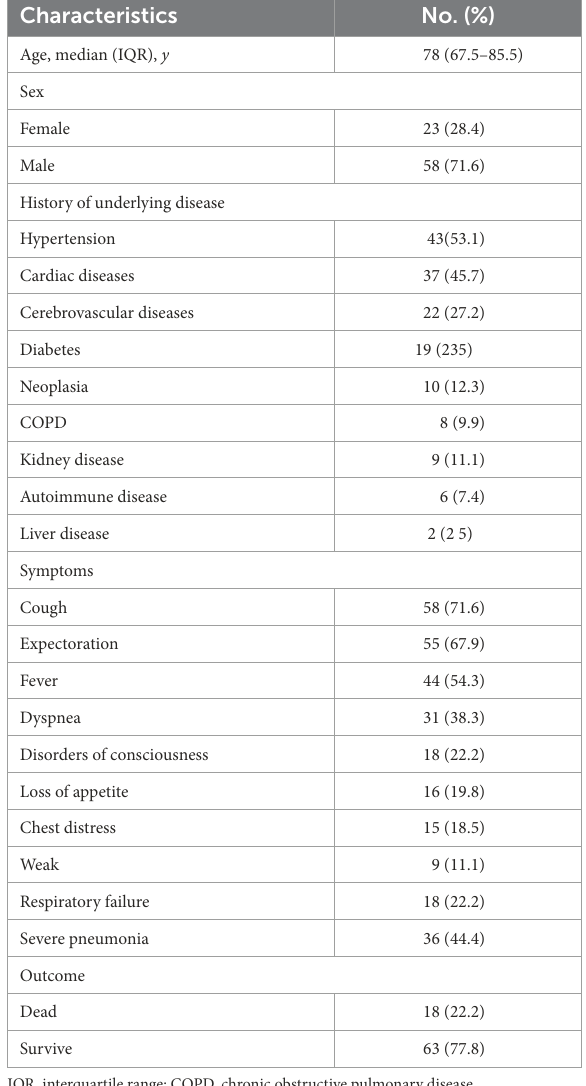
TABLE 1 Demographic and clinical characteristics of the 81 patients included in the study at baseline.